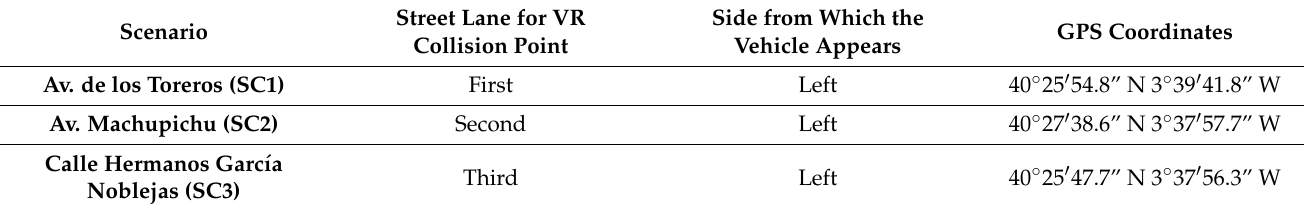
Table 1. Scenarios modeled in VR for the experimental session.